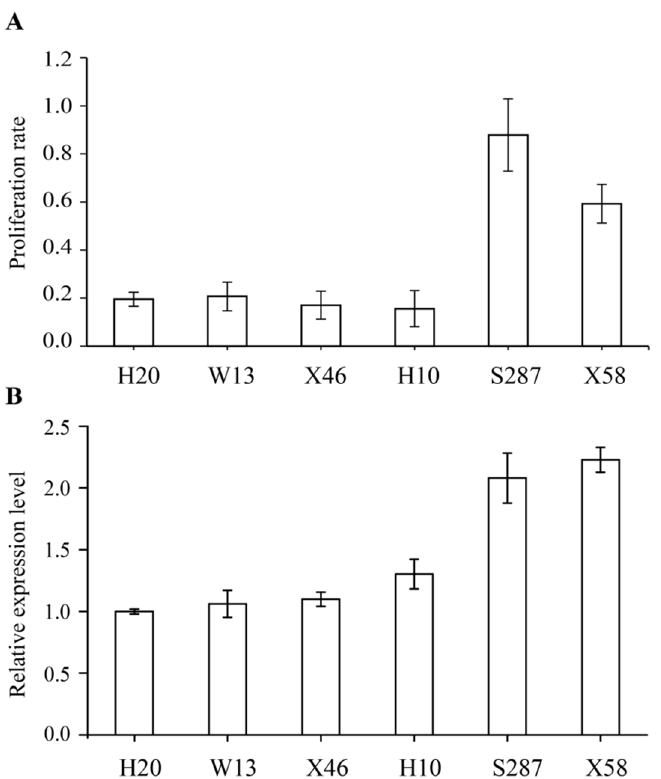
Figure 6. Proliferation rates of six L. kaempferi culture lines and expression pattern of LaCDKB1;2 . ( A ) Proliferation rates of six culture lines (H20, W13, X46, H10, S287, and X58), which are equal to the weights of increased cultures grown on a solid proliferation medium for 20 days divided by the weight on day 1. ( B ) Relative expression level of LaCDKB1;2 assayed by qRT-PCR with LaEF1A1 as the internal control. Data are presented as the mean ± SE.